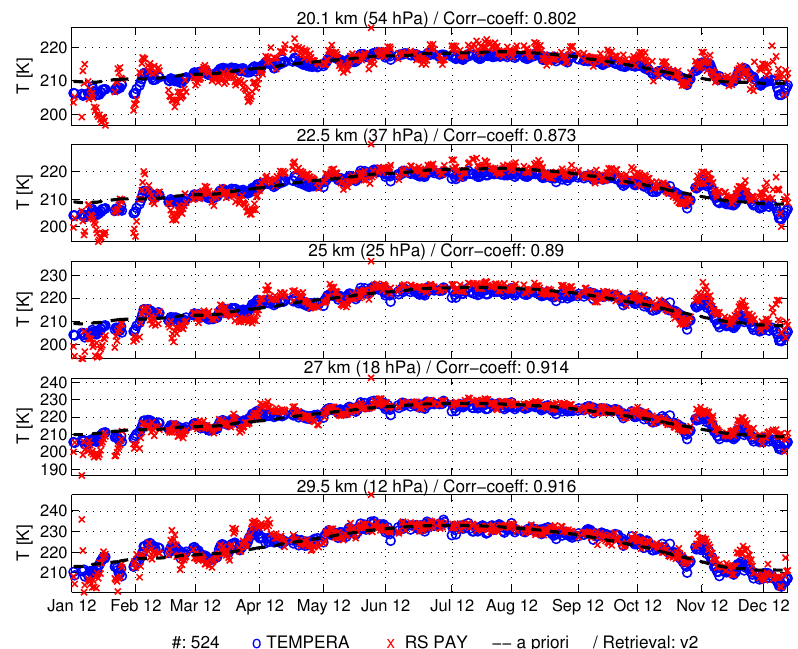
Fig. 16. Time series (524 profiles) of stratospheric temperature profiles from TEMPERA (blue) compared with radiosonde data from Payerne (red, regridded to TEMPERA grid) for five different altitude levels. The black dashed line is the a-priori.